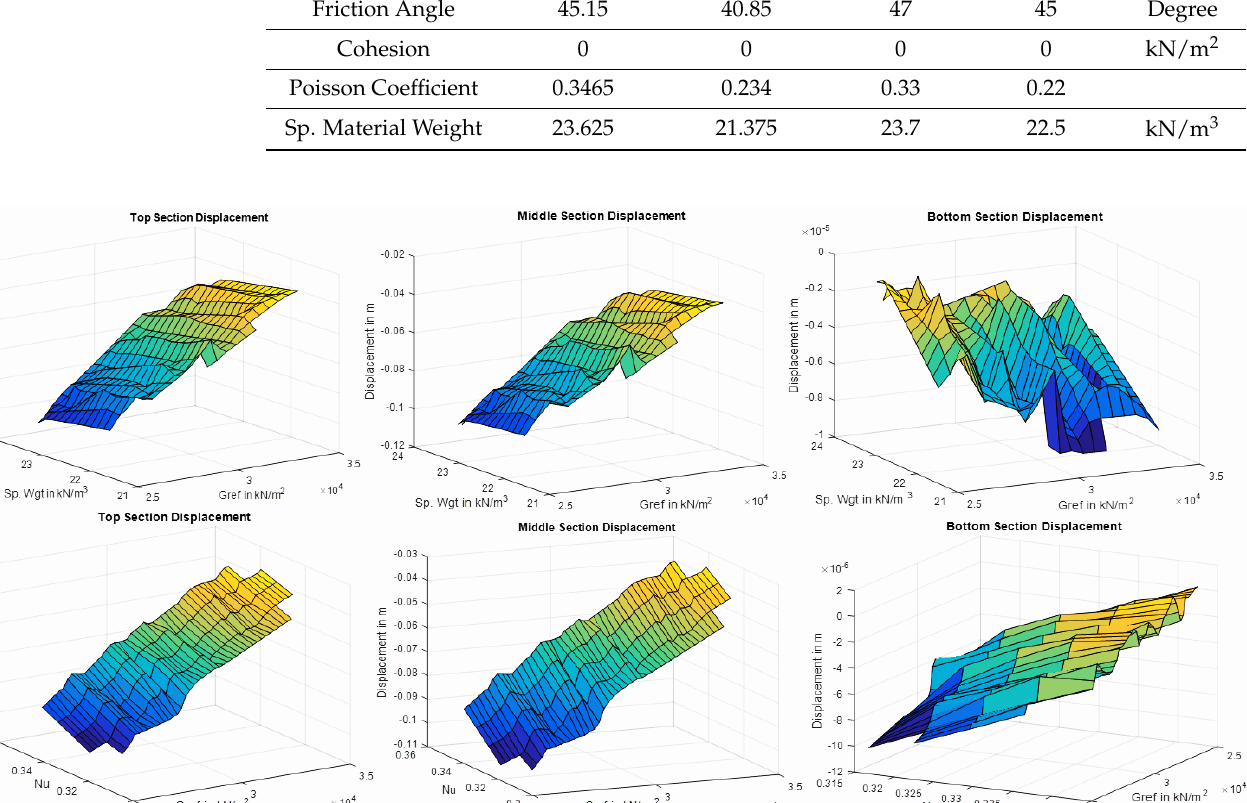
Table 2. The polynomial order used in the regression model and the corresponding root mean squared error.